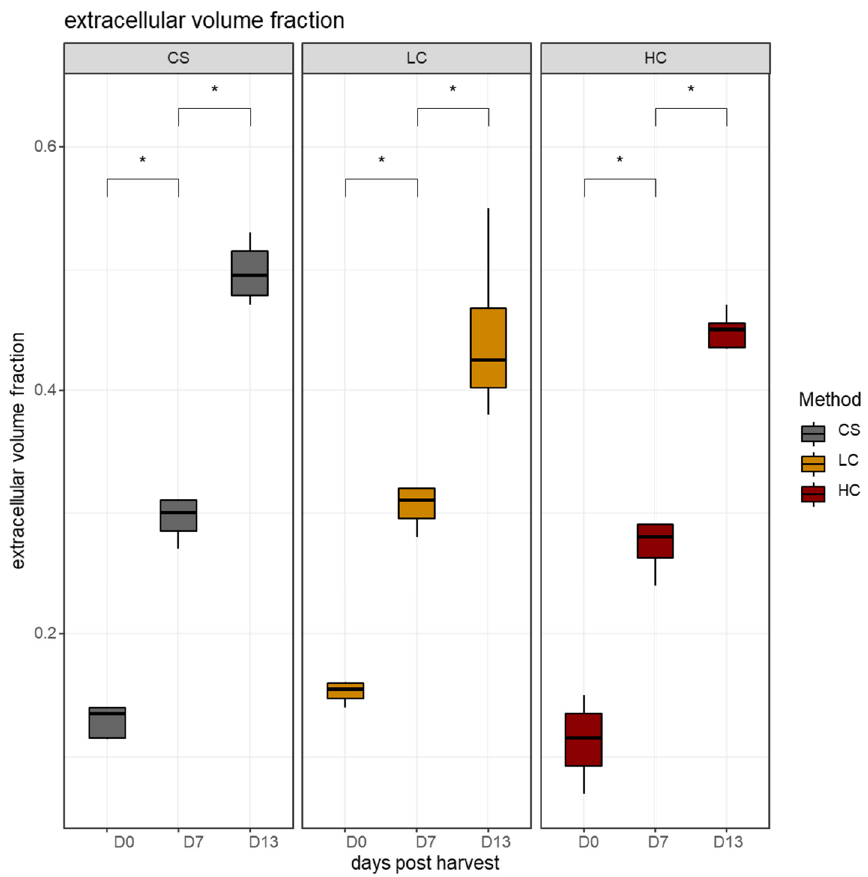
Figure 7. The volume density of the inter-fiber space in sampling days per harvest method. CS (gray): control group, LC (orange): low current group, HC (red): high current group. Superscripts indicate statistically significant differences between days in each harvest method (*: p < 0.05).